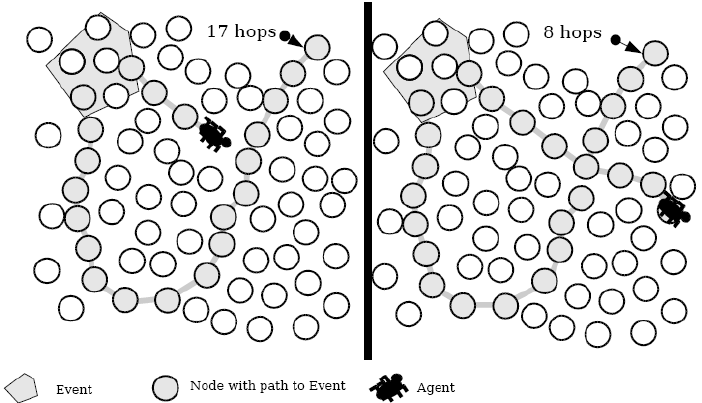
Figure 5. Agents optimize longer paths